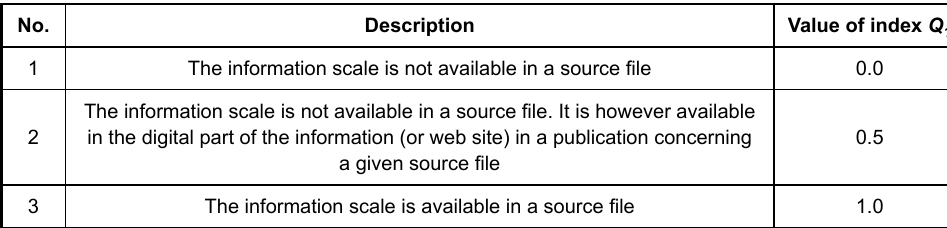
Table 1. Scale (legend) availability index Q 1